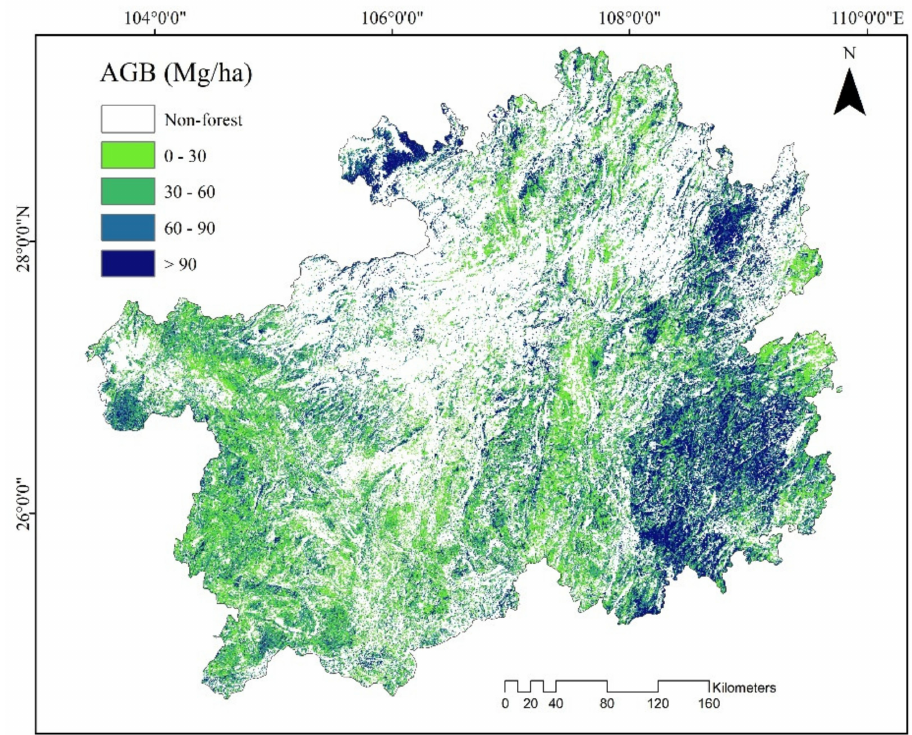
Figure 14. Forest aboveground biomass distribution map in Guizhou in